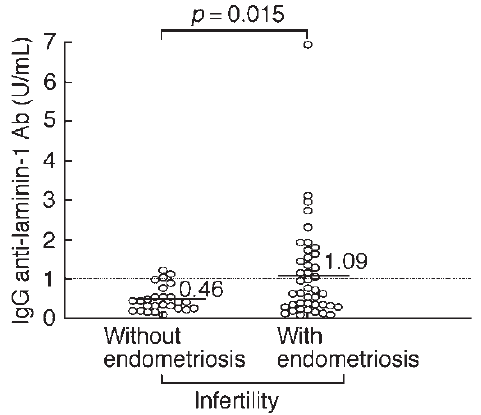
FIGURE 4 Comparison of IgG values of anti-laminin-1 antibodies between infertile patients with and without endometriosis. The dotted and solid lines show the cut off and meanvalues of the antibodies, respectively. (Inagaki et al. ,